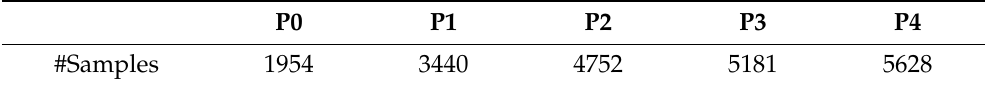
Table 3. Statistics about the dataset.